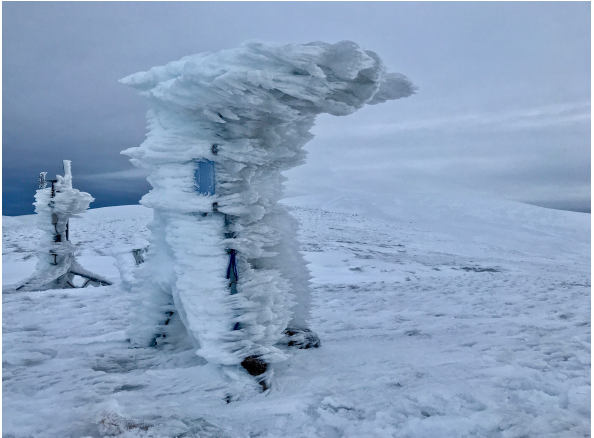
Figure 6. Disdrometer at Druim nam Bo, Scotland, covered in rime in January 2018. The instrument was still receiving power and recording nullified (no beam received by optical diode) data, which it interpreted as a “sensor error” ( − 1) present weather